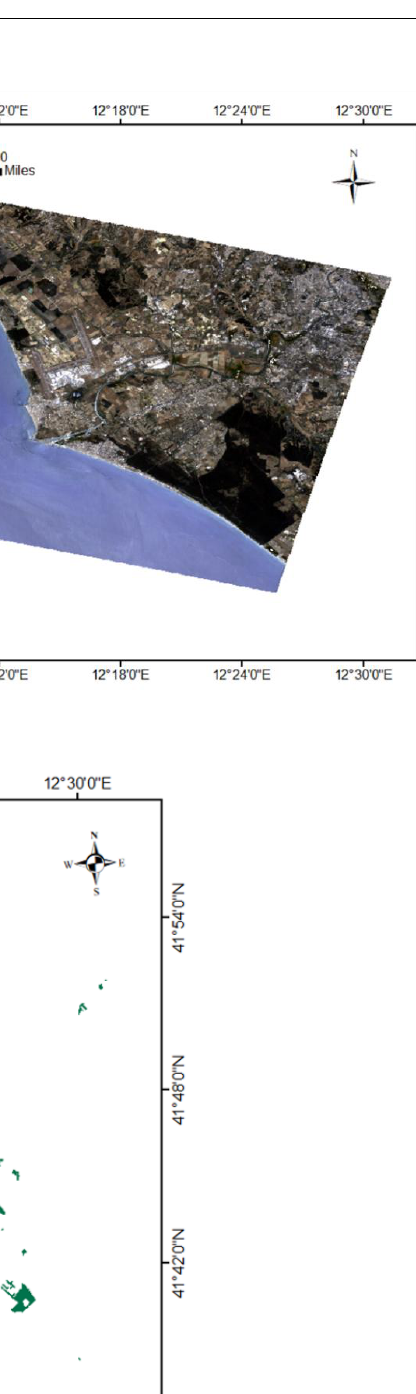
Figure 2. Pine trees (genus Pinus ) — reference data.